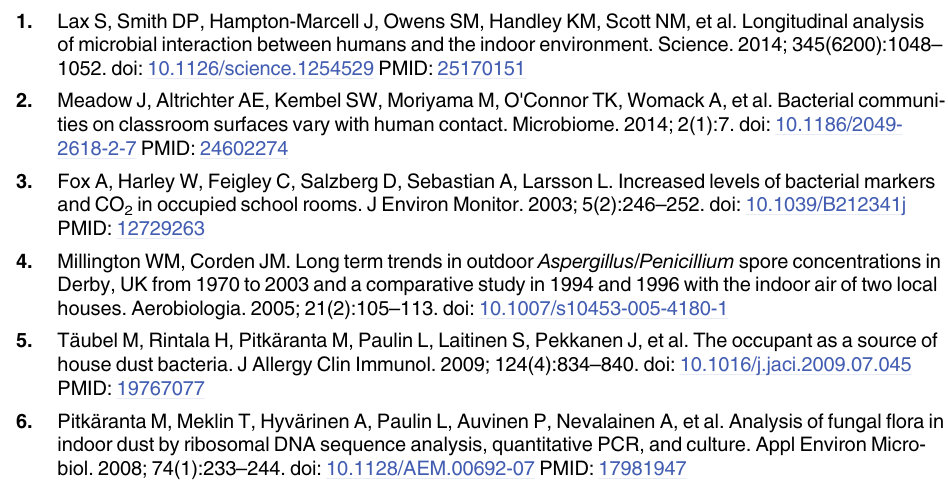
Fig 2 of the main text. S3 Fig. Observed OTU richness across the occupancy levels. Fungi are on top while bacteria are on bottom, and richness is split across indoor (left) and outdoor (right) samples. S4 Fig. Fraction of the mean indoor concentration of total particles larger than 5 μ m that is attributable to occupancy. Results are based on particles measured during the second hour of each